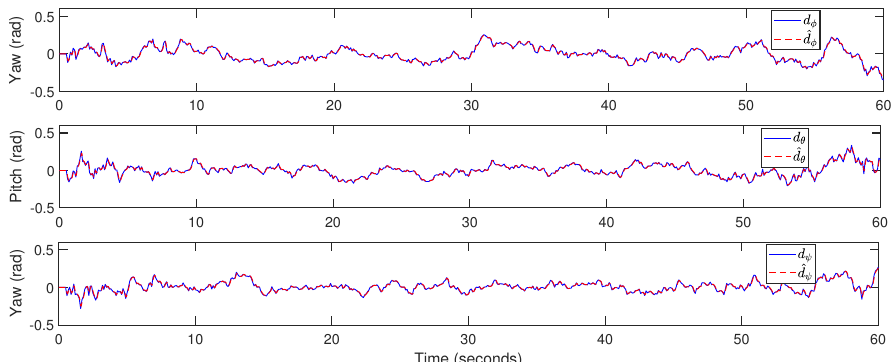
Figure 22. Disturbance observer outcome for attitude subsystem with Von Karman wind turbu- lence